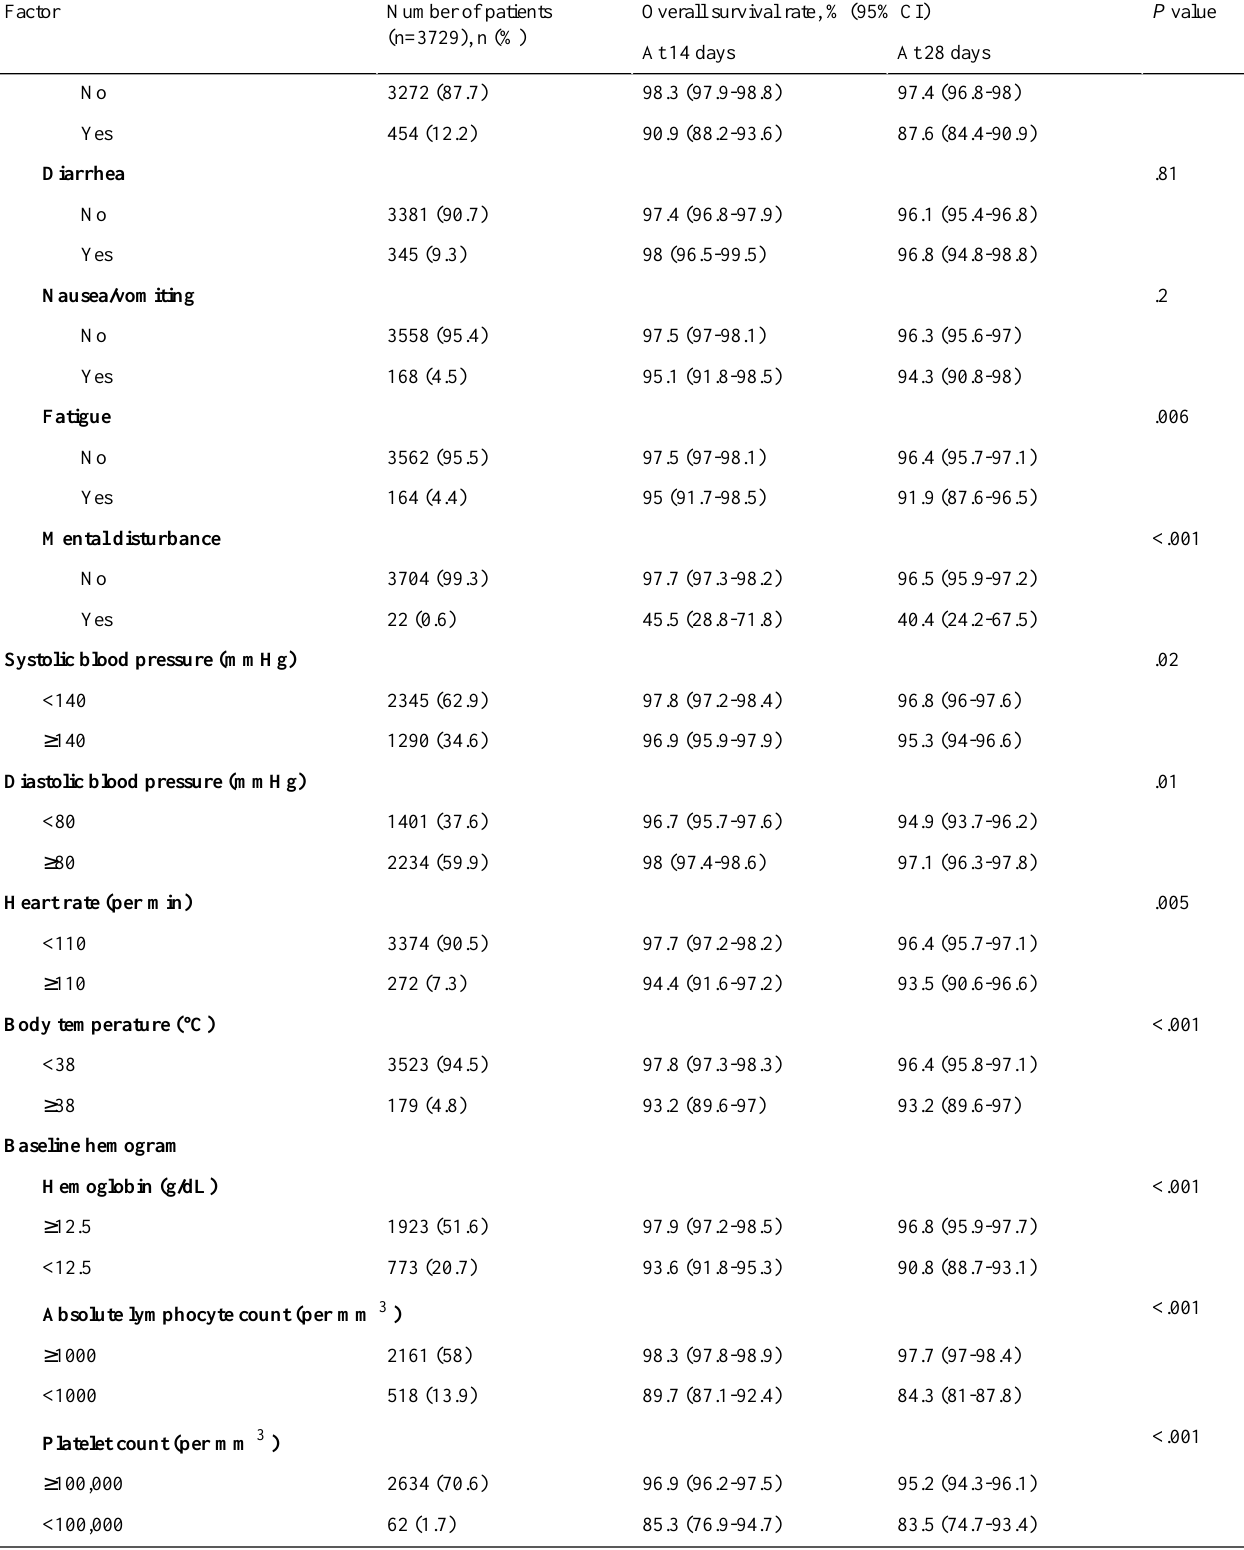
a Chronic cardiac disease was a composite variable including heart failure and cardiac disease. b Chronic pulmonary disease was a composite variable including asthma and chronic obstructive lung